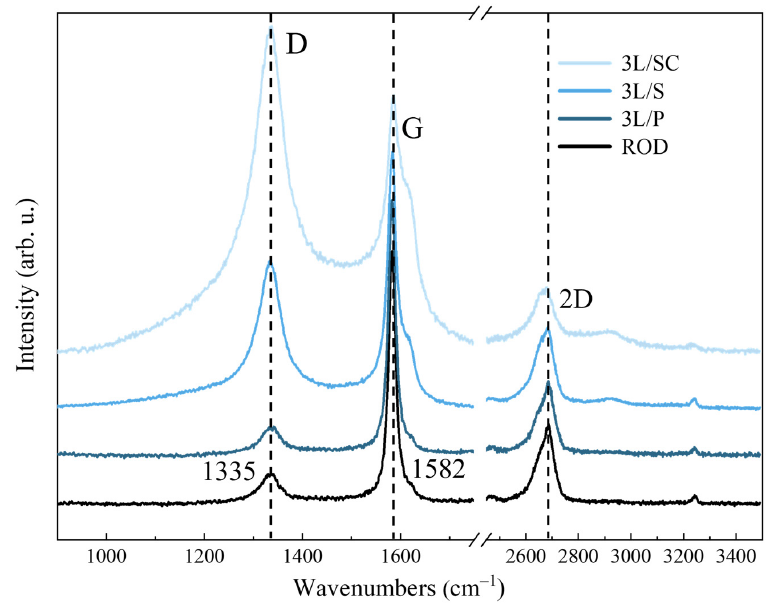
Figure 9. Raman ( λ exc = 633 nm) spectra of the pristine synthetic graphite sample (ROD) and of the commercial 3L GNPs (3L/P: the pristine sample; 3L/S: the sample after sonication in water; 3L/SC: the sample after sonication and centrifugation).